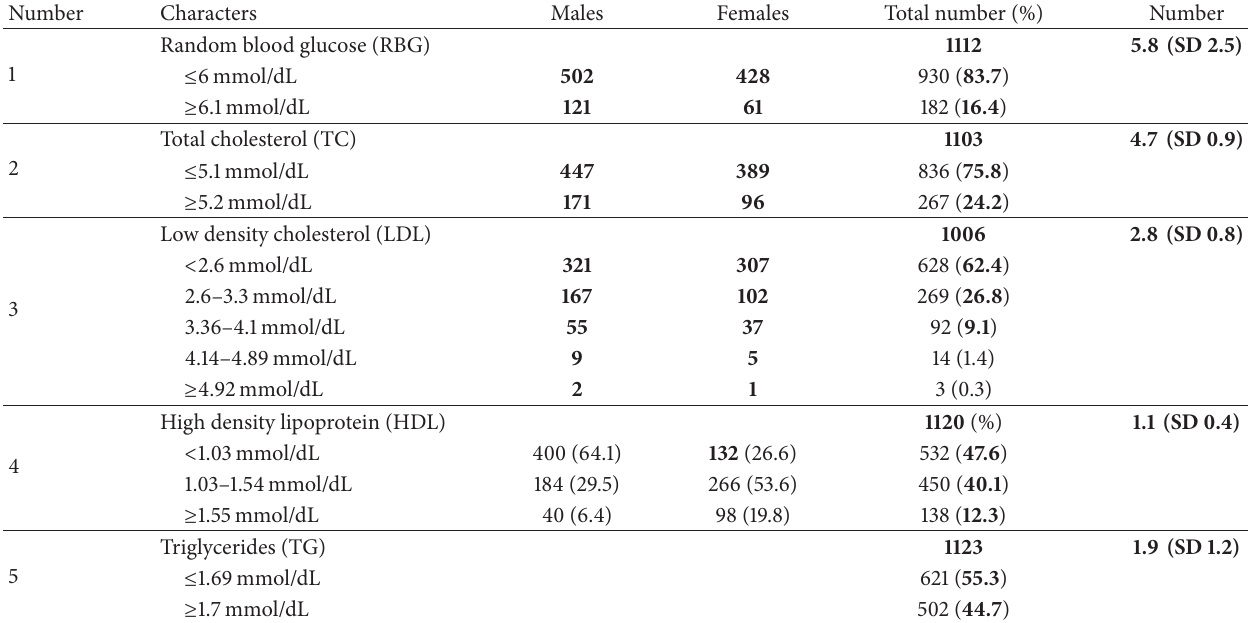
Table 3: The biochemical measurements of the participants (employees).